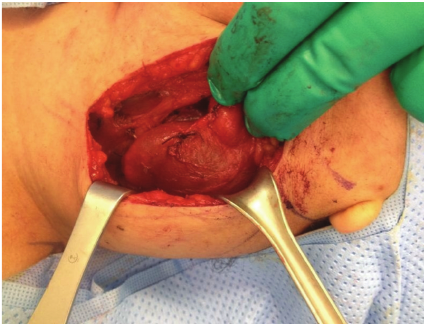
Figure 6: Intraoperative picture showing the lesion underneath the sternocleidomastoid muscle compressing medially on left internal jugular